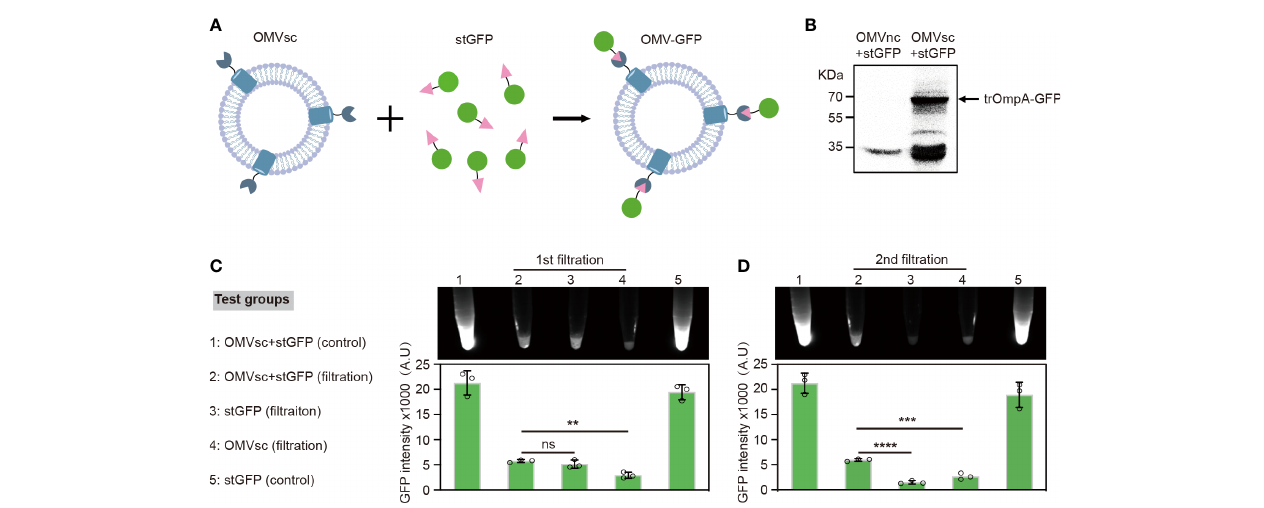
FIGURE 2 Click display of GFP on engineered OMVs. (A) A schematic diagram of the click display of GFP on the surface of OMVsc. (B) Detection of the assembly between OMVsc and stGFP by western blot. OMVsc and OMVnc were incubated with stGFP separately and unbond stGFP was washed subsequently. The trOmpA-GFP fusion protein was detected by using an anti-His 6 primary antibody. (C) Detection of the fl uorescence of OMV-GFP. OMVsc were incubated with stGFP at room temperature to allow in vitro binding. The mixing sample, sfGFP and OMVsc alone were subjected to two rounds of ultra fi ltration. Fluorescent images were taken after each around of ultra fi ltration and fl uorescent intensity was quantitatively analyzed (n=3). An OMVsc and stGFP mixing group and a stGFP group were used as non-ultra fi ltration control. The data are shown as mean ± SD. Statistical analysis was performed by one way ANOVA. ns: not signi fi cant; ** P < 0.01; *** P < 0.001; **** P <